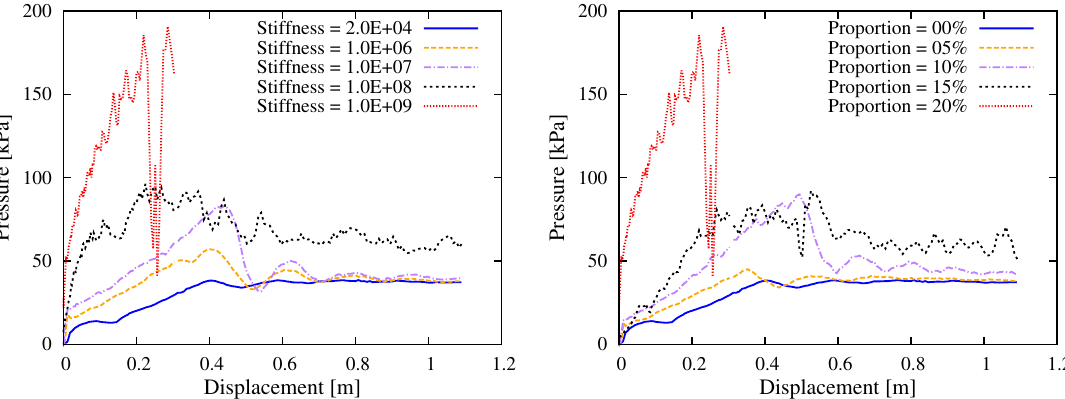
Figure 17. Simulation results with respect to the hydration degree: ( left ) curves of the thrusting pressure vs. displacement relationship for different values of hydrated bond stiffness; and ( right ) curves of the thrusting pressure vs. displacement relationship for different proportions of hydrated